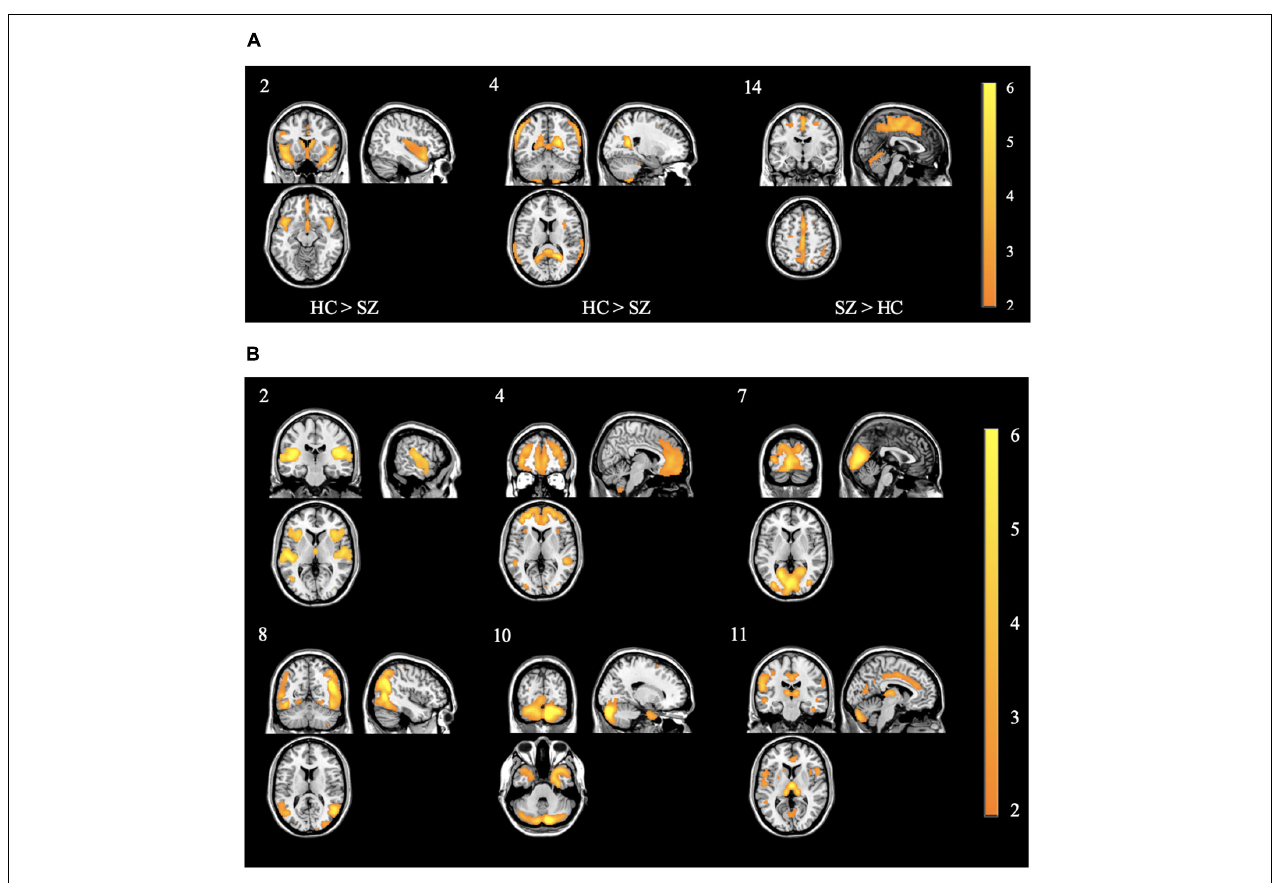
FIGURE 3 | (A) Spatial patterns of the concentration components showing control > case effect from the primary SBM decomposition. Component 2 showed the strongest control > case effect Of Note. All images are thresholded at | z | > 2. The color bar indicates the color mapping for the component weights. Component numbers are listed in the top left corner of every image. HC: healthy controls; SZ: individuals with schizophrenia. (B) Spatial patterns of the volume components showing control > case effect from the primary SBM decomposition. Of note, component 2 showed similar patterns to concentration component 2 in panel (A) Of Note. All images are thresholded at | z | > 2. The color bar indicates the color mapping for the component weights. Component numbers are listed in the top left corner of every image. All components showed control > case